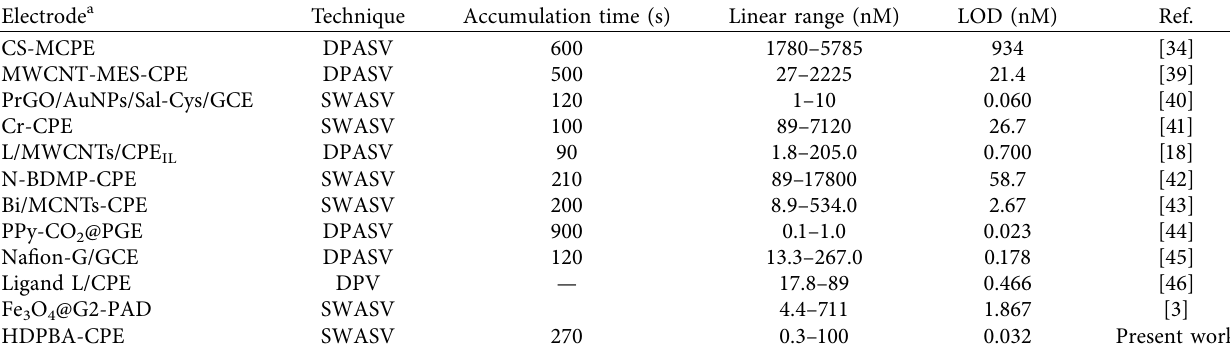
Table 3: Comparison of the performance of HDPBA modified CPE with other reported sensors for the determination of Cd(II). Electrode a Technique Accumulation time (s) Linear range (nM) CS-MCPE DPASV MWCNT-MES-CPE L/MWCNTs/CPE IL DPASV